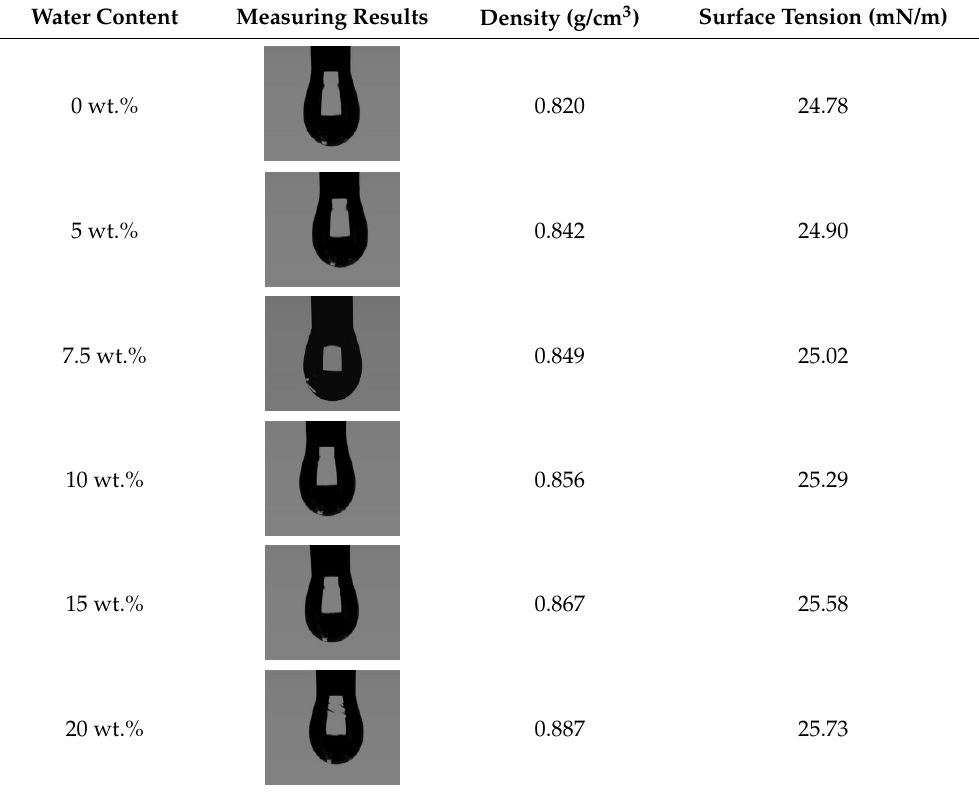
Table 1. Surface tension of polishing fluids with different water contents.